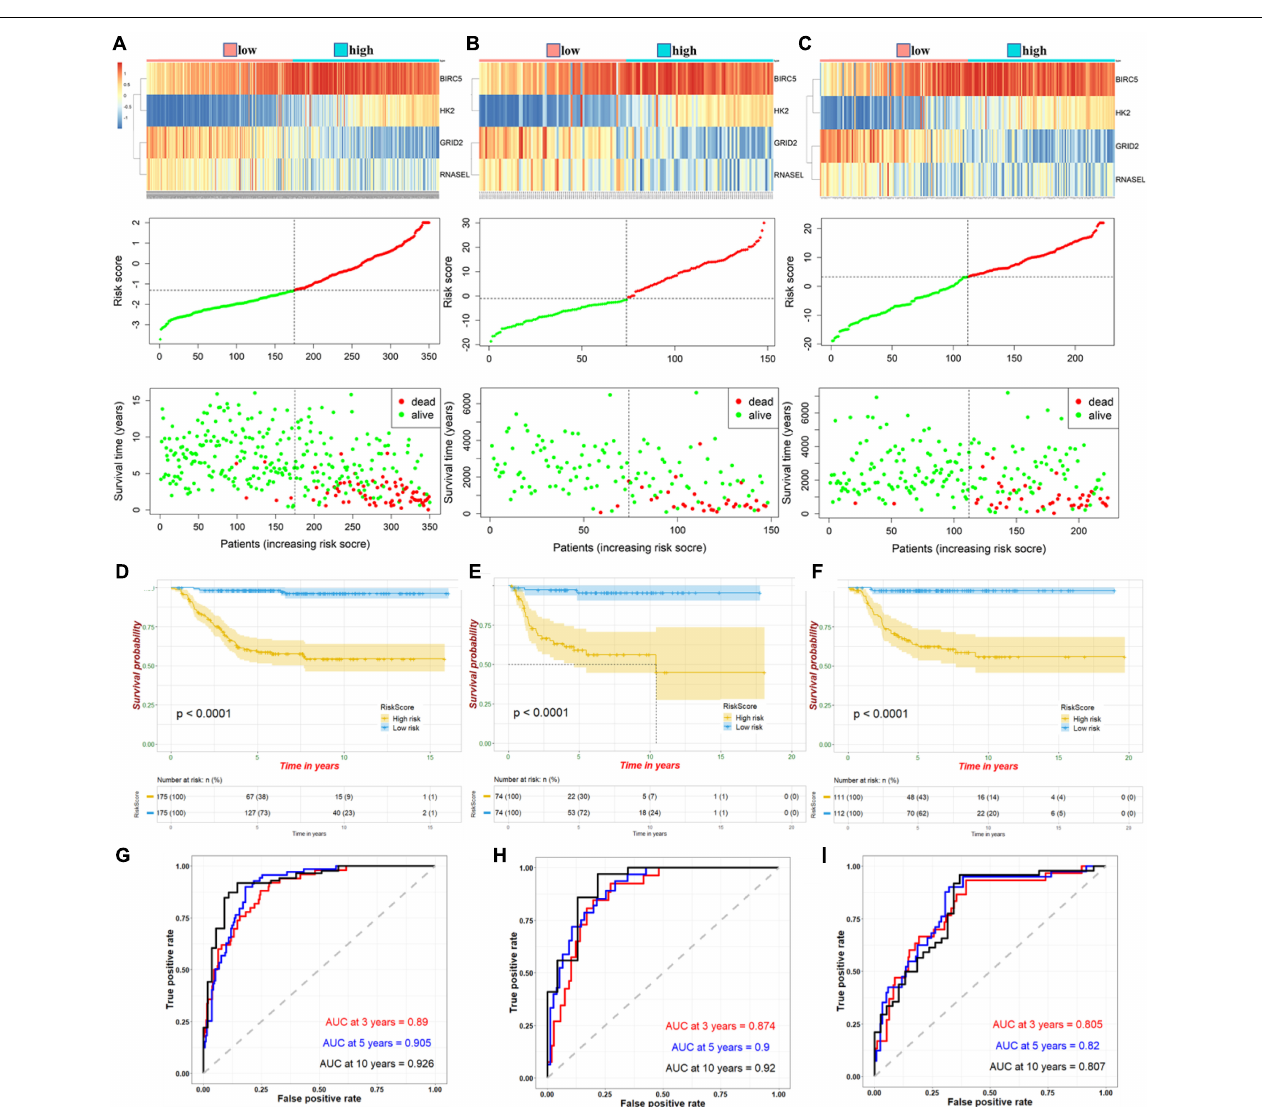
FIGURE 2 | Expression of high- and low-risk groups under ATG prognostic risk signature in samples. Expression heatmap of identified four ATGs and corresponding risk score and survival status of patients in training cohort (A) , internal (B), and external validation (C) . Kaplan–Meier curve for high- and low-risk group patients in training cohort (D) , internal (E), and external validation (F) . Time-dependent ROC curve of risk score in training cohort (G) , internal (H), and external validation (I) .